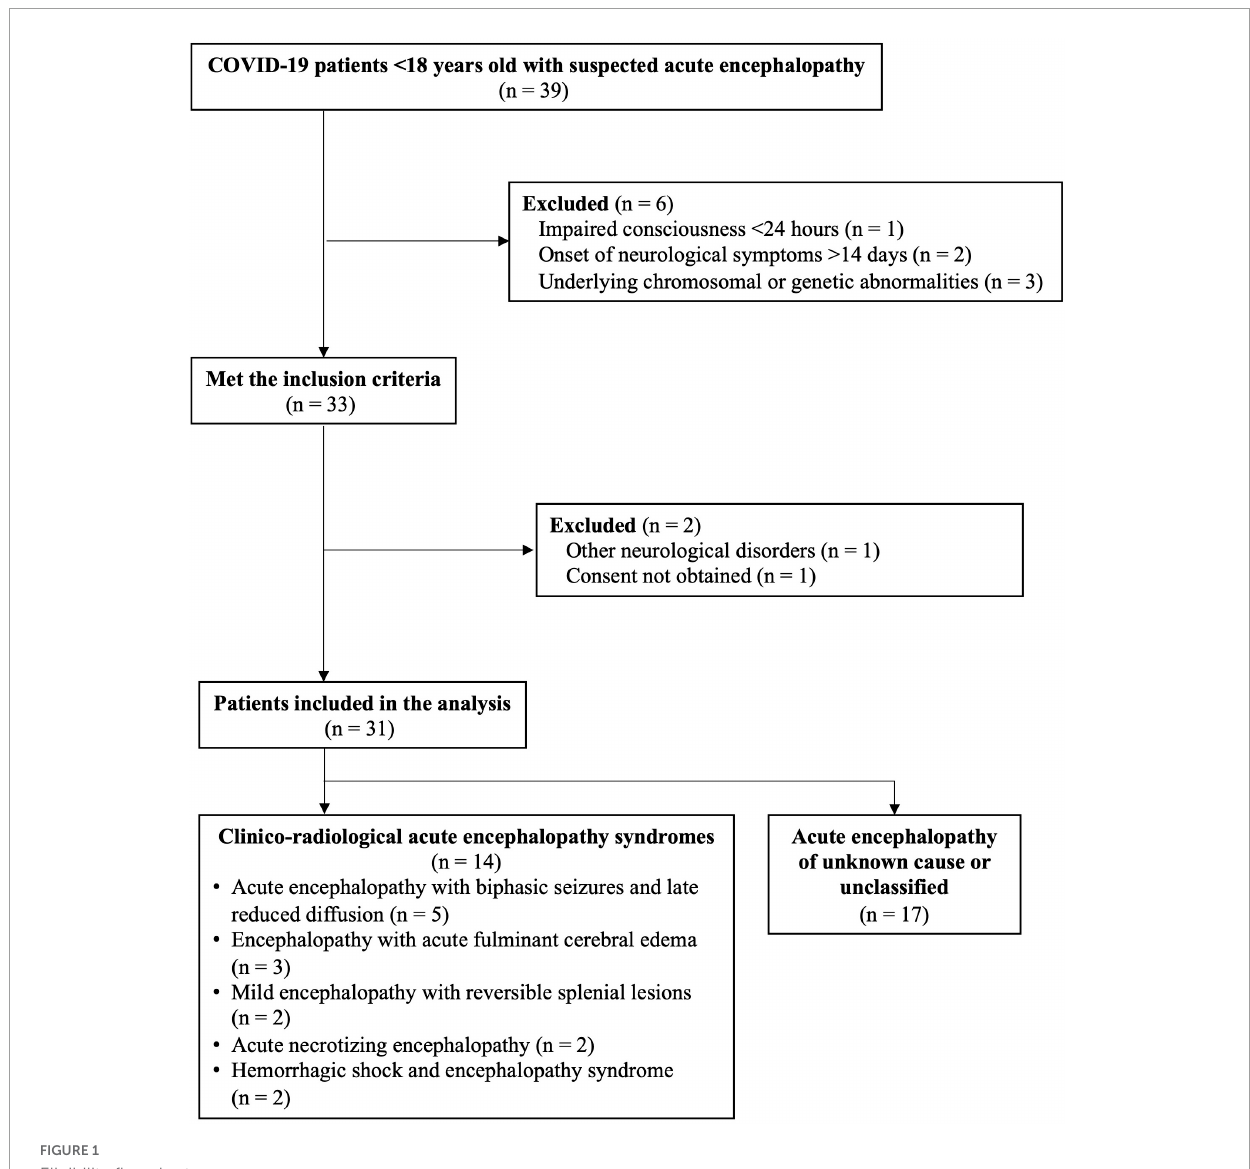
FIGURE1 Eligibility